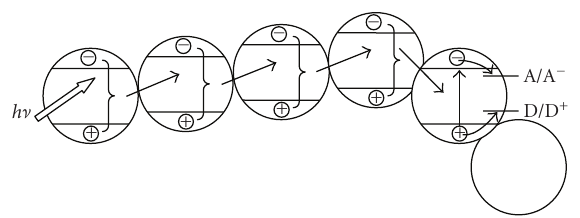
Figure 12: The scheme of increased photocatalytic activity through energy/exciton transfer in aggregated photocatalyst particles (an- tenna e ff ect). A and D represent electron and hole scavengers, re- spectively.